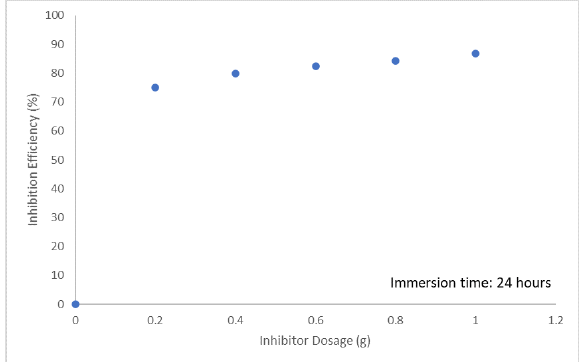
Fig. 2. Effect of inhibitor dosage on inhibition efficiency of mild steel acid corrosion.